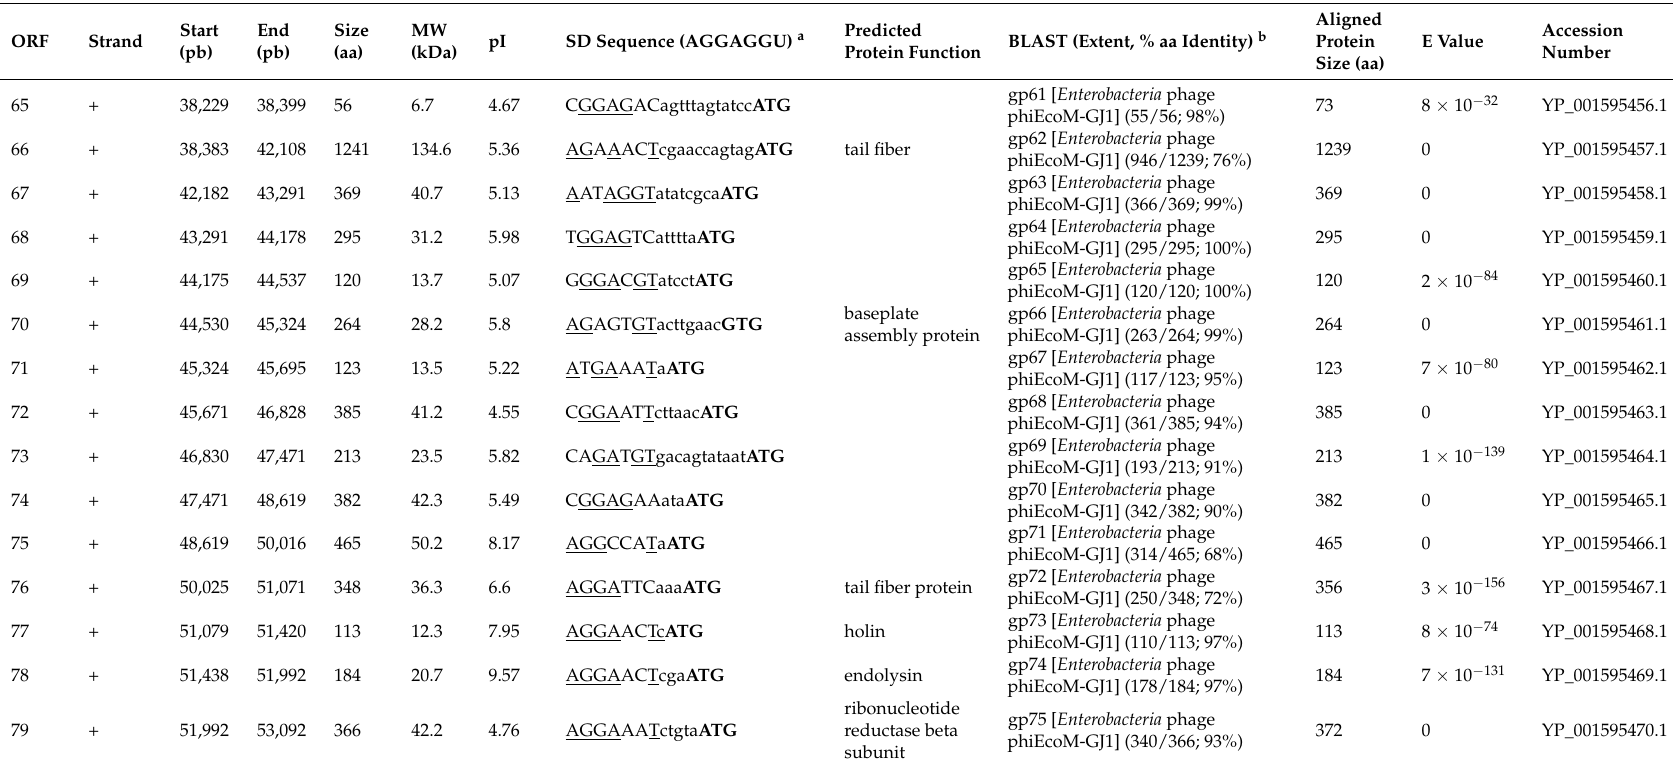
a Start codon indicated in bold; Match to SD sequence is indicated by underlining; SD position is indicated in uppercase. b The number of identical amino acids/The total of amino acids of smallest